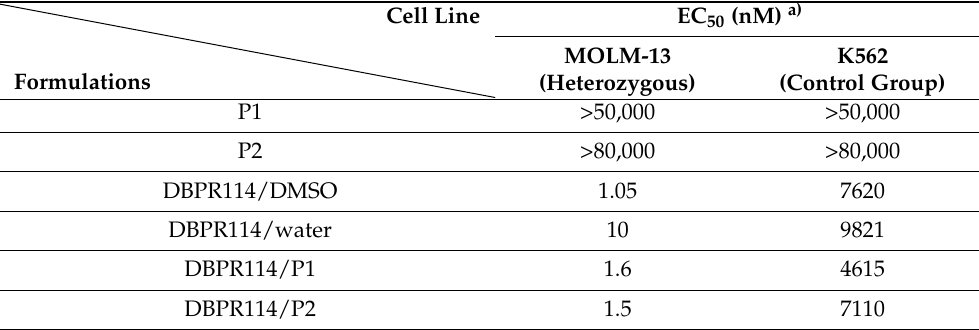
Table 2. The anti-proliferative activity of DBPR114 on leukemia cell